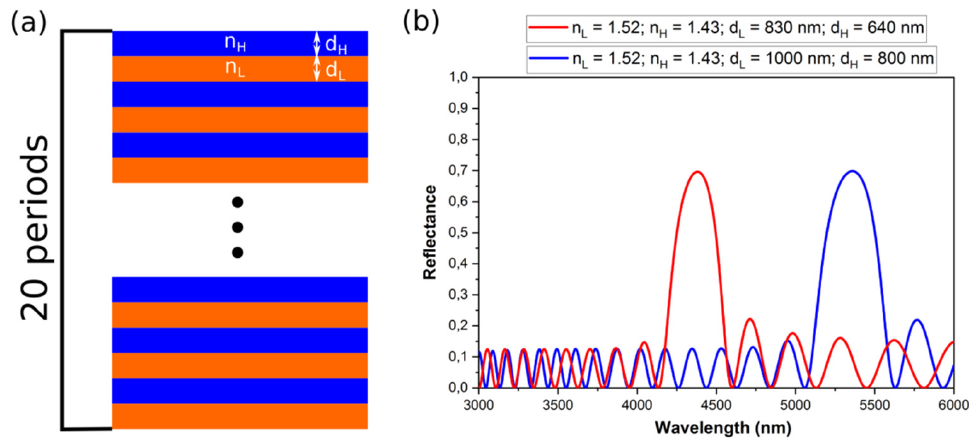
Figure 9. A scheme of the PAA-based DBR ( a ); the reflectance spectra of two DBR structures with the same number of d H + d L pairs (20 periods), ∆ n = 0.06 and different optical thickness d n eff ( b ).